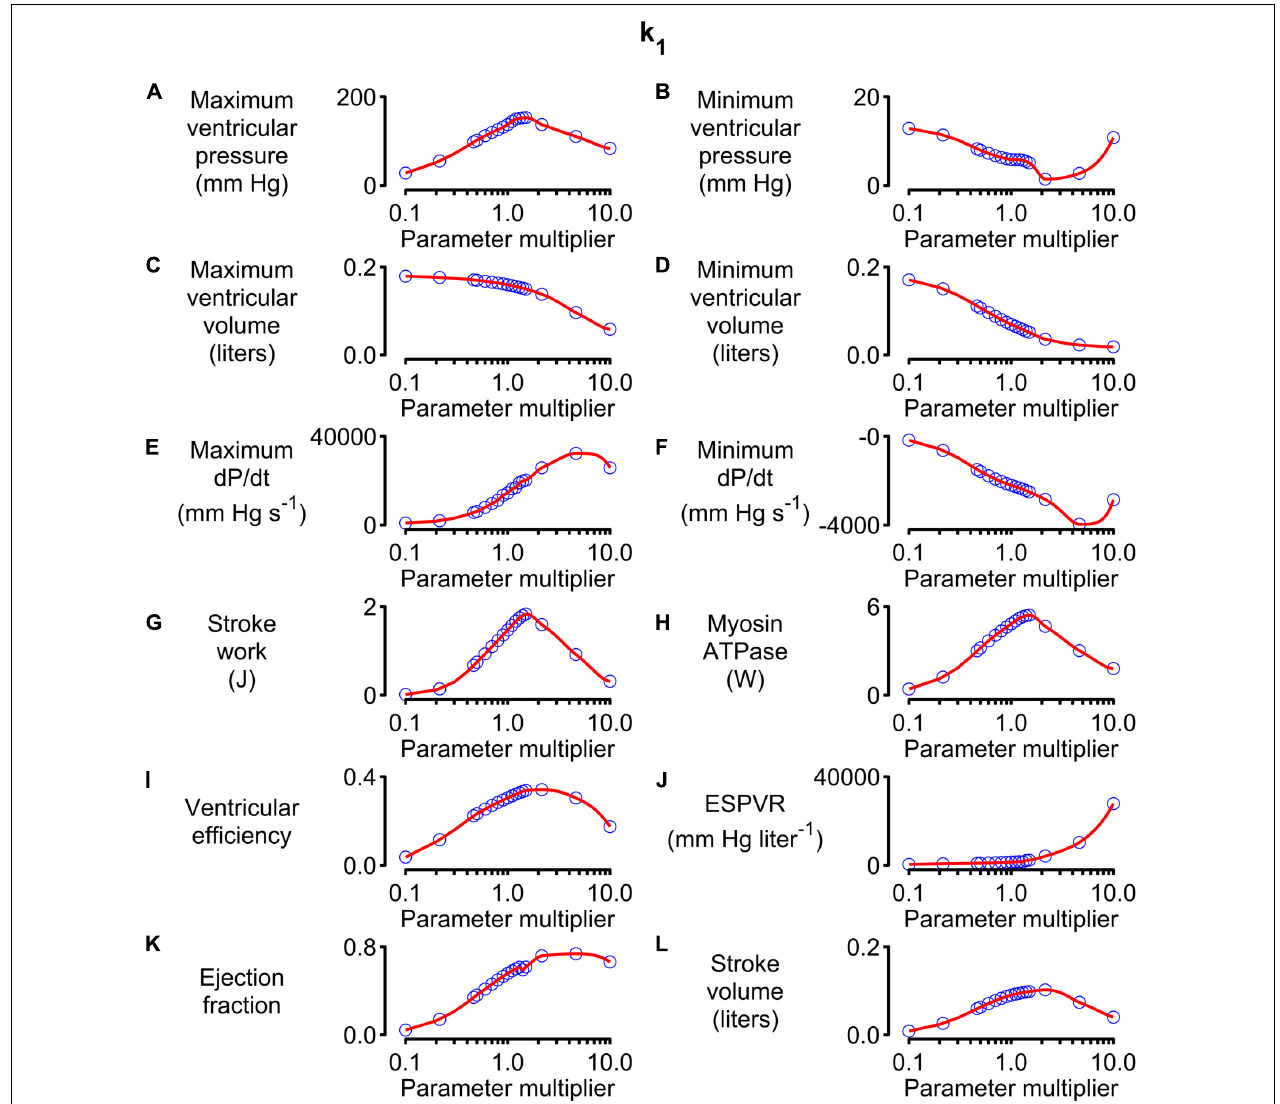
FIGURE 5 | Effects of changing k 1 on system-level properties. (A–L) Show values (blue circles) for 12 system-level properties (for example, maximum ventricular pressure) predicted for values of k 1 ranging from 0.1 to 10 times the value shown in Supplementary Table S1 . The red lines show the best-fit of a 5th order polynomial to the simulated data. The relative sensitivity for each property was defined as the slope of the polynomial at the base parameter value (that is, when the multiplier was 1) divided by the corresponding y value. The division normalized the slope to facilitate comparisons between different